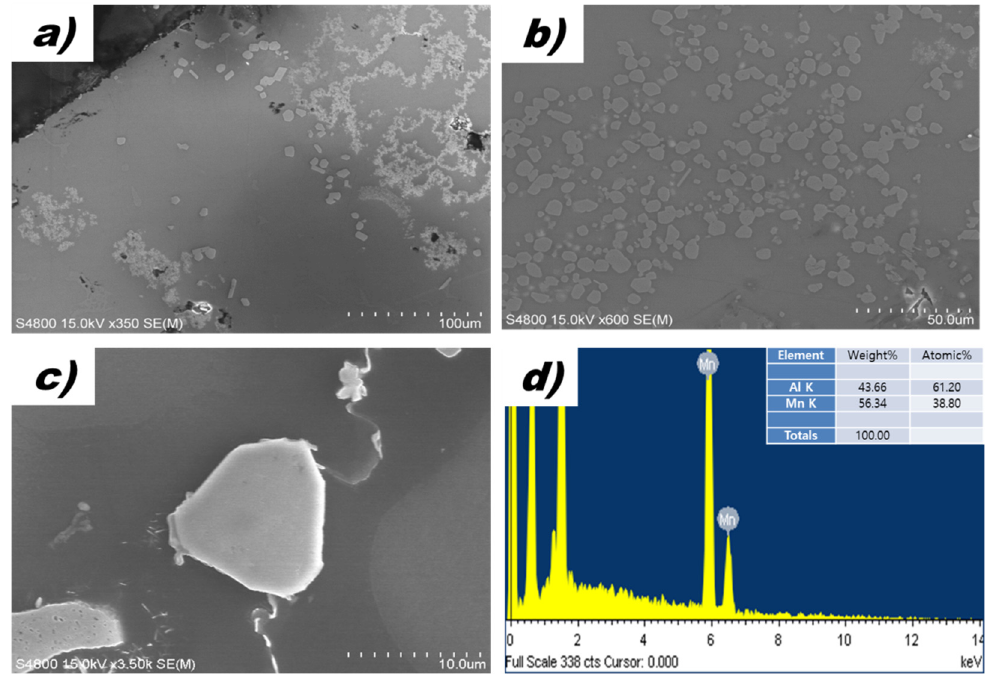
Figure 7. Intermetallic compounds of CP AZ91 filtered through a 10 µ m filter ( a ) before superheating and ( b ) after superheating; ( c ) Al-Mn intermetallic compound of sample before superheating; ( d ) EDS analysis for Al–Mn intermetallic compound of sample before superheating.